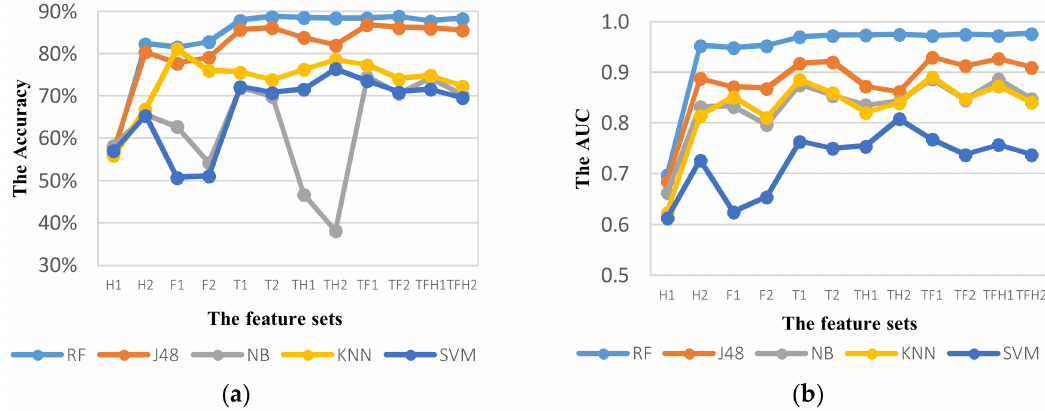
Figure 10. The activity mode detection system performance of classifiers using different feature sets with the window size of 5 s at 50% overlapping based on the metric: ( a ) Accuracy; ( b )